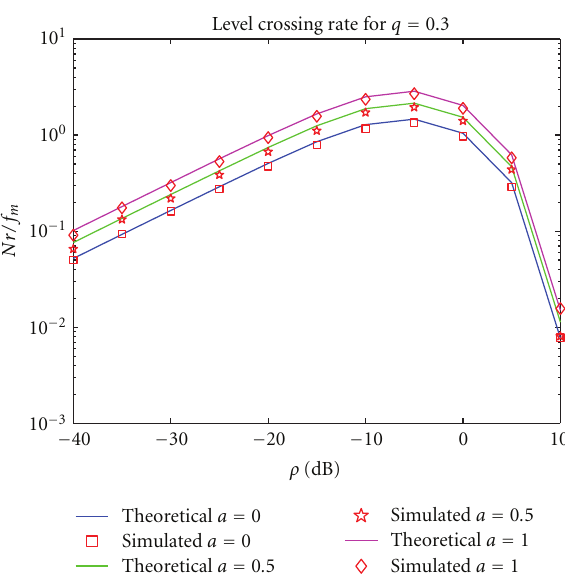
Figure 10: Level crossing rates for q = 1, k = 3.